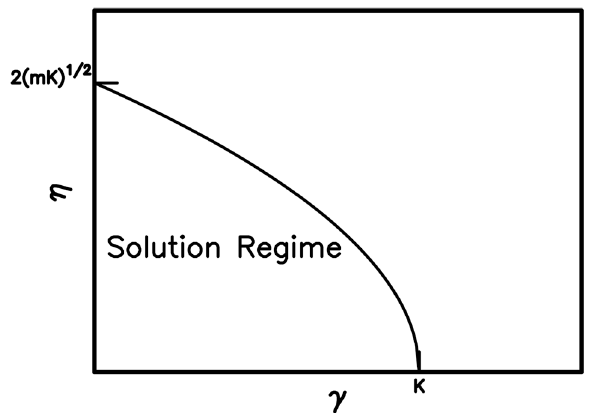
Figure 4. The solution regime of h and c based on K described by the parabolic equation: h 2 +4 m c = 4 mK for the one-body spring- slider model.